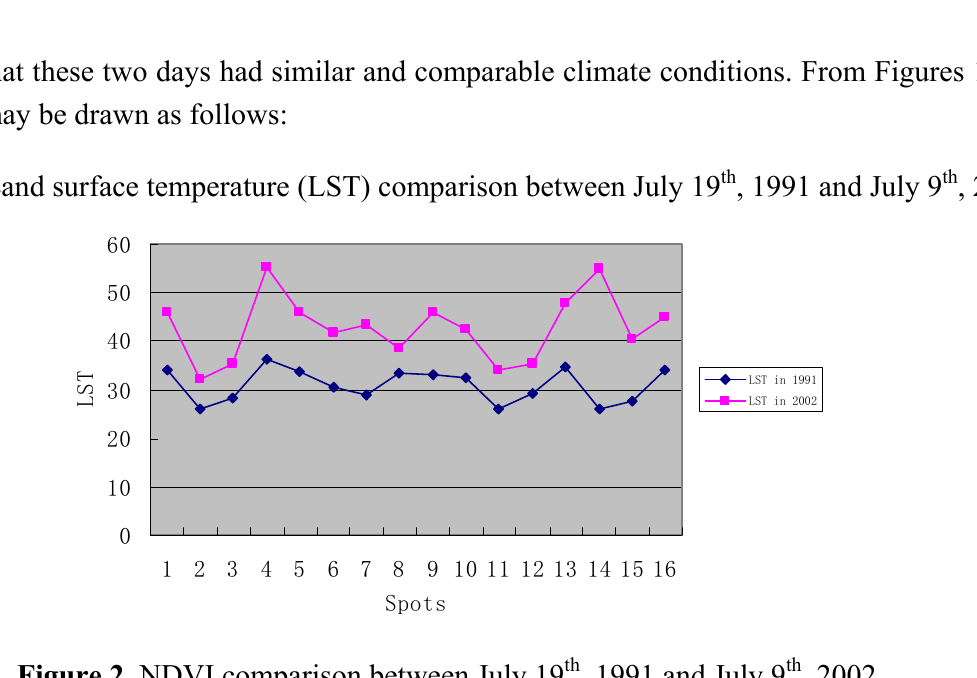
Figure 2. NDVI comparison between July 19 th , 1991 and July 9 th ,